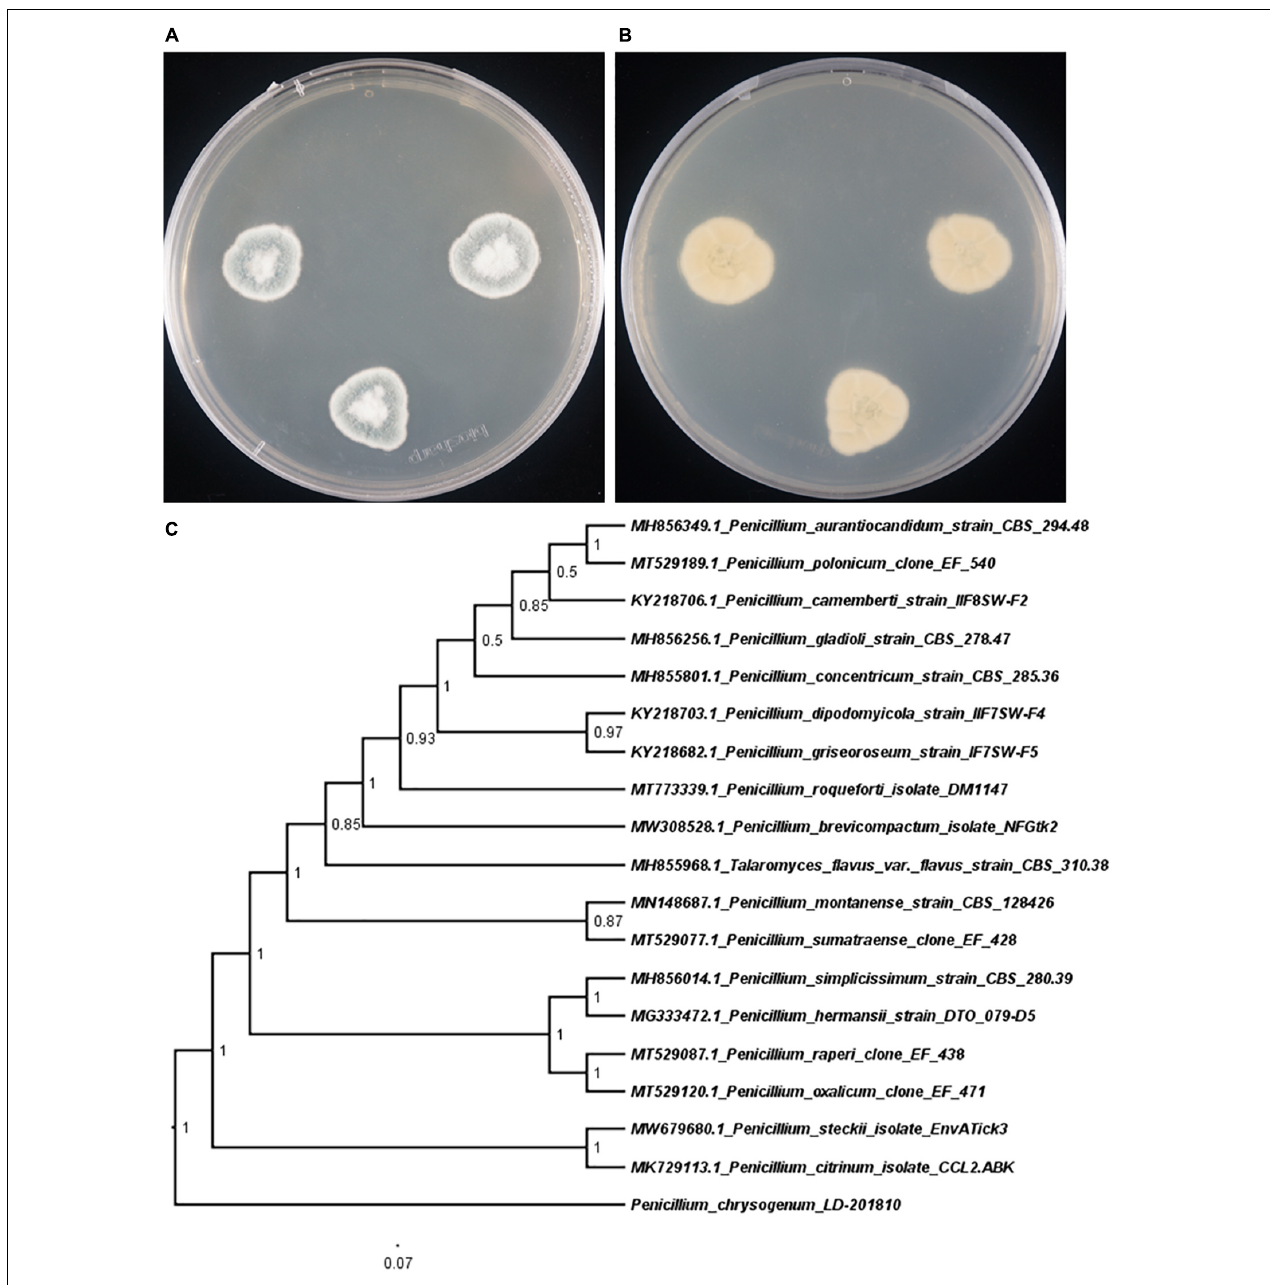
FIGURE 2 | Morphology of P. chrysogenum LD-201810 on PDA medium ( A , front view; B , reverse view). (C) Neighbor-joining tree based on ITS nucleotide sequences.